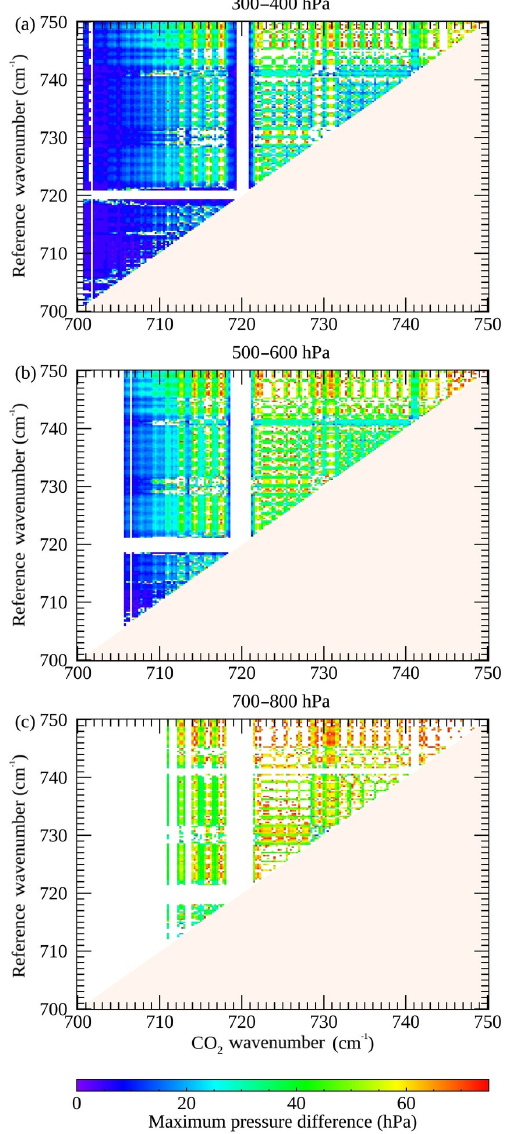
Figure 4. CO 2 slicing results for RTTOV simulated ash spectra. The plots show the maximum difference between the true (simulated) pressure and the pressure obtained with the CO 2 slicing algorithm. The results are split into three pressure levels: (a) high cloud (300– 400hPa), (b) mid-level cloud (500–600hPa) and (c) low-level cloud (700–800hPa). Note that, in this plot, results for 200 and 900hPa are excluded. Results are only included where the maximum differ- ence is less than 75hPa and the percentage of successful retrievals is greater than 50%. This was used to inform the choice of channels for the final CO 2 slicing algorithm.